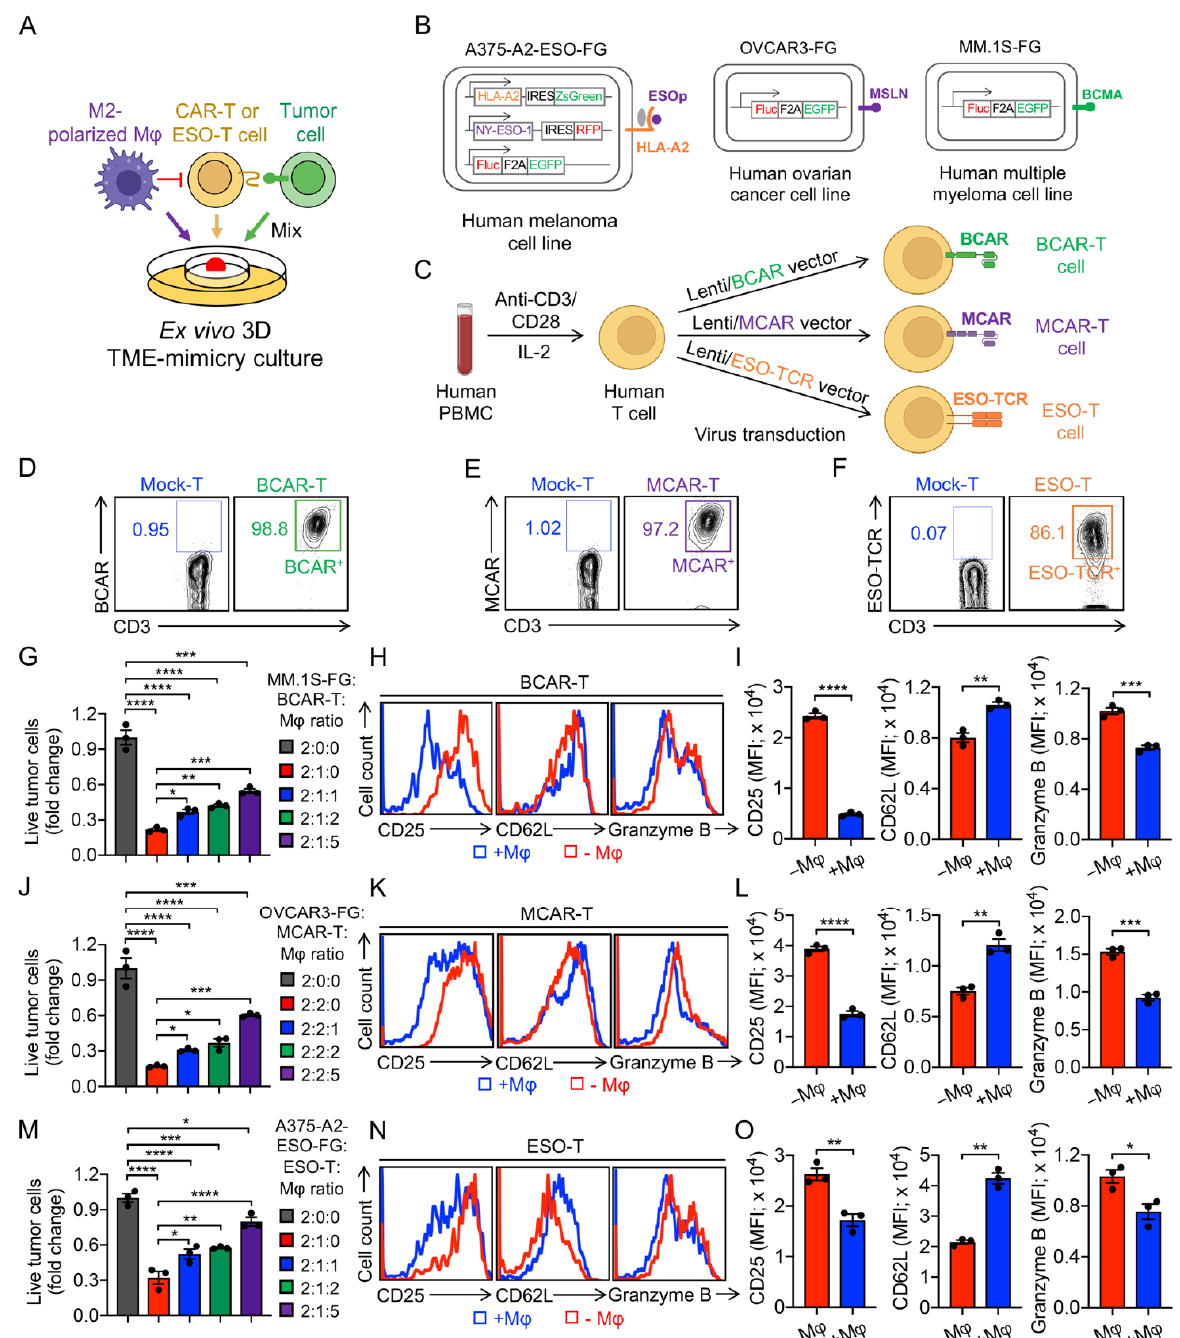
Figure 3. Development of an ex vivo 3D TME-mimicry culture to study TAM modulation of T-cell antitumor reactivity. ( A ) Diagram of an ex vivo 3D TME-mimicry culture. Three human tumor cell lines were studied: MM.1S (multiple myeloma), OVCAR3 (ovarian), and A375 (melanoma). ( B ) Schematics showing the engineered MM.1S-FG, OVCAR3-FG, and A375-A2-ESO-FG cell lines. Fluc, firefly luciferase; EGFP, enhanced green fluorescent protein; FG, Fluc-EGFP; F2A, foot-and- mouth disease virus 2A; RFP, red fluorescent protein; NY-ESO-1, New York esophageal squamous cell carcinoma-1; ESOp, ESO peptide; IRES, internal ribosome entry site; HLA, human leukocyte antigen. ( C – F ) Generation of BCMA CAR-engineered T (BCAR-T), mesothelin CAR-engineered T (MCAR-T), and HLA-A2-restricted, NY-ESO-1 tumor antigen-specific human CD8 TCR-engi- neered T (ESO-T) cells. ( C ) Experimental design. ( D – F ) FACS detection of BCAR on BCAR-T cells ( D ), MCAR on MCAR-T cells ( E ), and ESO-TCR on ESO-T cells ( F ). Human T cells that received